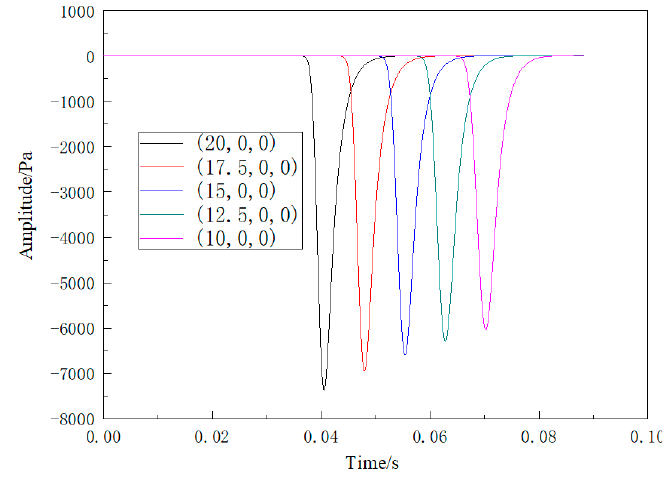
Figure 8. Amplitude changes of acoustic pressure when acoustic waves propagate upstream. The amplitude changes are shown in Table 4. Table 4. Amplitudes and TCs at different monitoring points when acoustic waves propagate up- stream.